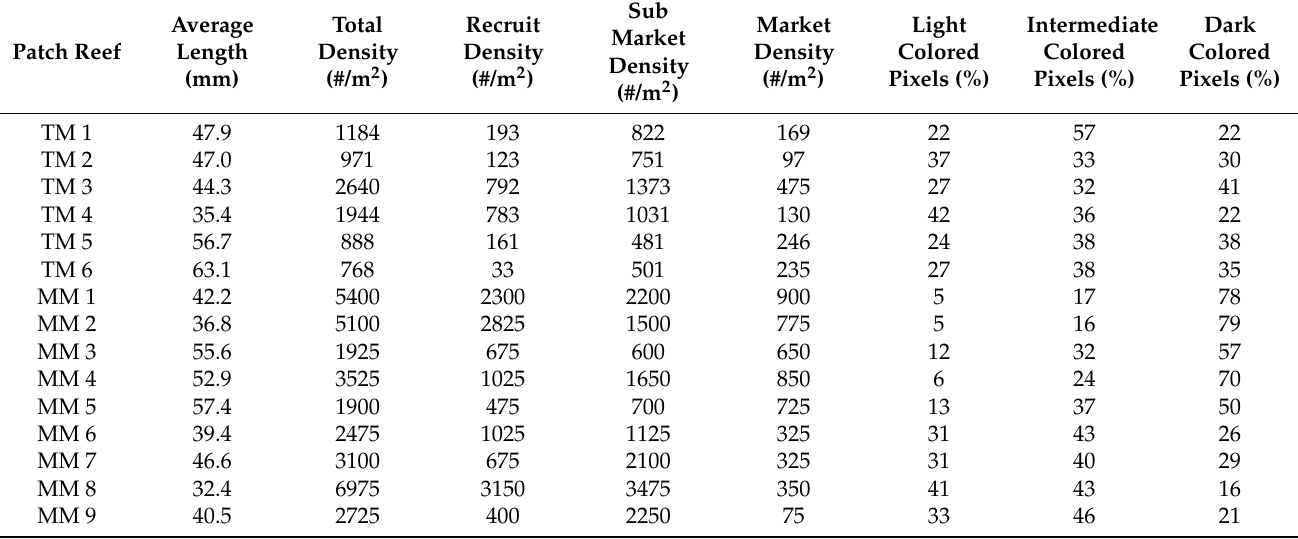
Table A1. Spectral and structural metrics applied in